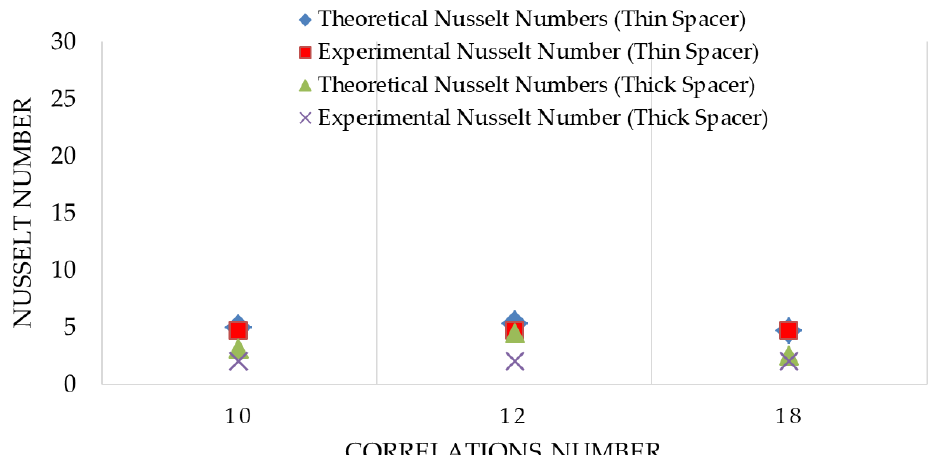
Figure 17. Laminar flow correlation for spacer-filled channels with flow rate (3 L/min).